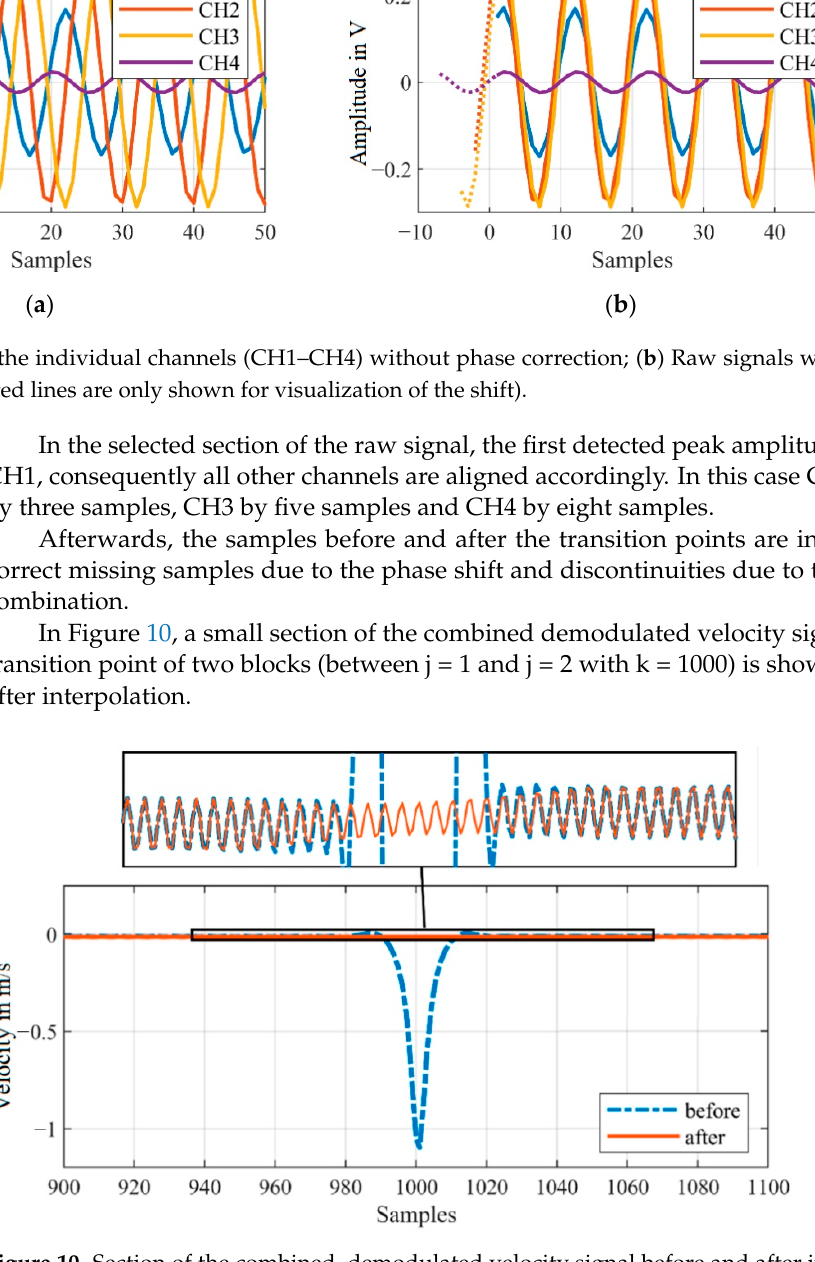
Figure 10. Section of the combined, demodulated velocity signal before and after interpolation to correct discontinuities and error due to phase shifting.